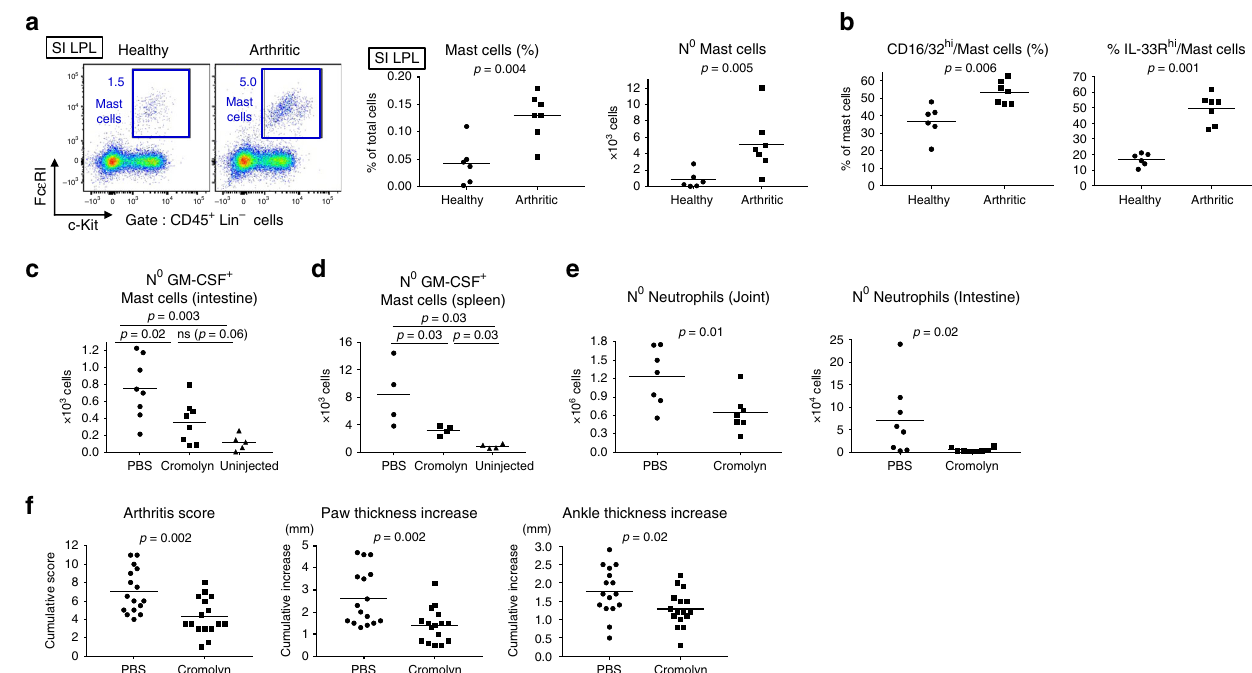
Fig. 6 Mast cells are activated and their inhibition dampens SpA. a FACS staining, frequencies and absolute numbers of MCs in the SI LPL of healthy vs. spondyloarthritic (week 5) SKG mice. b Percentage of CD16/32 hi and ST2 hi cells among MCs in SI LPL. c – e SKG mice were treated daily with PBS or cromolyn sodium following SpA induction and culled at week 4. Healthy SKG mice ( “ uninjected ” ) were used as controls in ( c , d ). c Absolute numbers of GM-CSF + MCs in the SI LPL. d Absolute numbers of GM-CSF + MCs in the spleen. e Absolute numbers of neutrophils in joints and SI. f Clinical score of arthritis, ankle, and paw size increase. Dots represent individual mice; horizontal bars indicate mean. Data are representative of ( a – e ) or pooled from ( f ) two independent experiments. Groups were compared using Mann – Whitney U tests. Source data are provided as Source Data fi twice weekly IL-33 injections for 5 weeks (Fig. 7c). This treatment